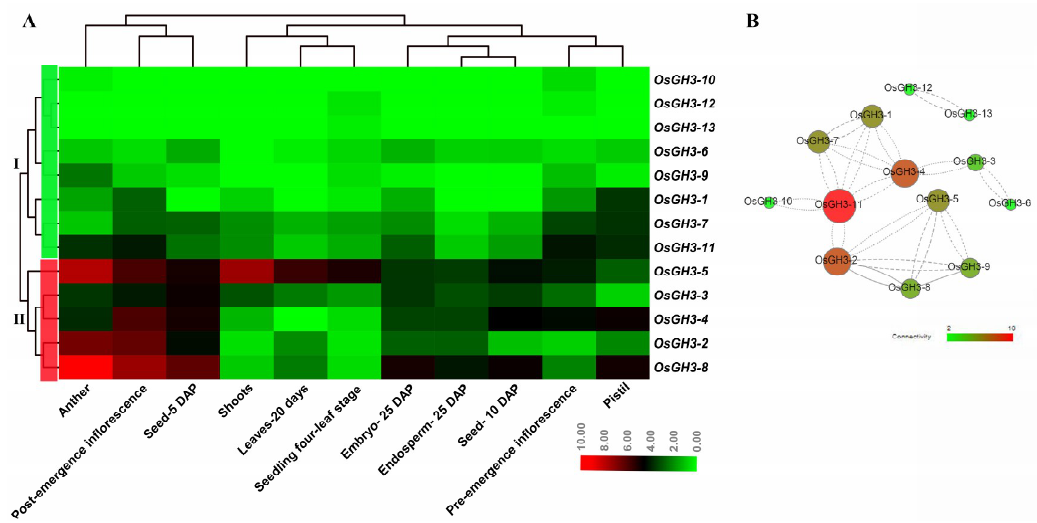
Figure 7. Expression profiles of OsGH3 genes in different tissues (A) and a co-expression network diagram of OsGH3 genes in different tissues. A: The color scale at the bottom of the image represents log 2 FPKM ; red indicates a high level; and green represents a low level of transcript abundance. B: The Correlation from weak to strong is shown by dotted line to solid line. Connectivity from weak to strong is shown from green to red. DAP, days after pollination.